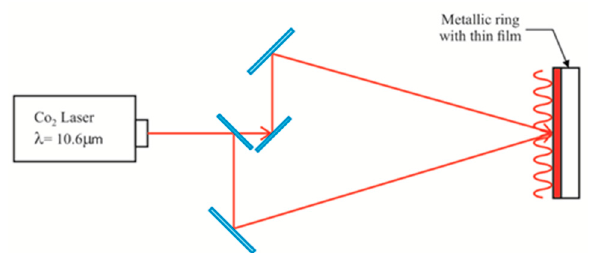
Figure 13. Infrared interferometric optical configuration to record the gratings on the surface of thin films. The sinusoidal red line represents the IR intensity field.